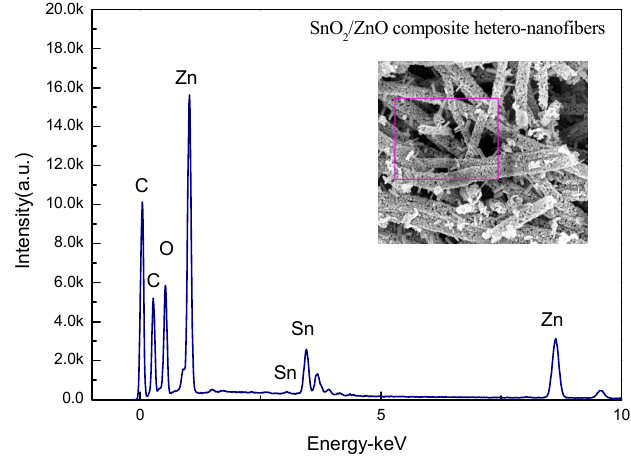
Figure 3. A typical EDS spectrum of the prepared electrospun SnO 2 /ZnO 3D hetero-nanofibers.